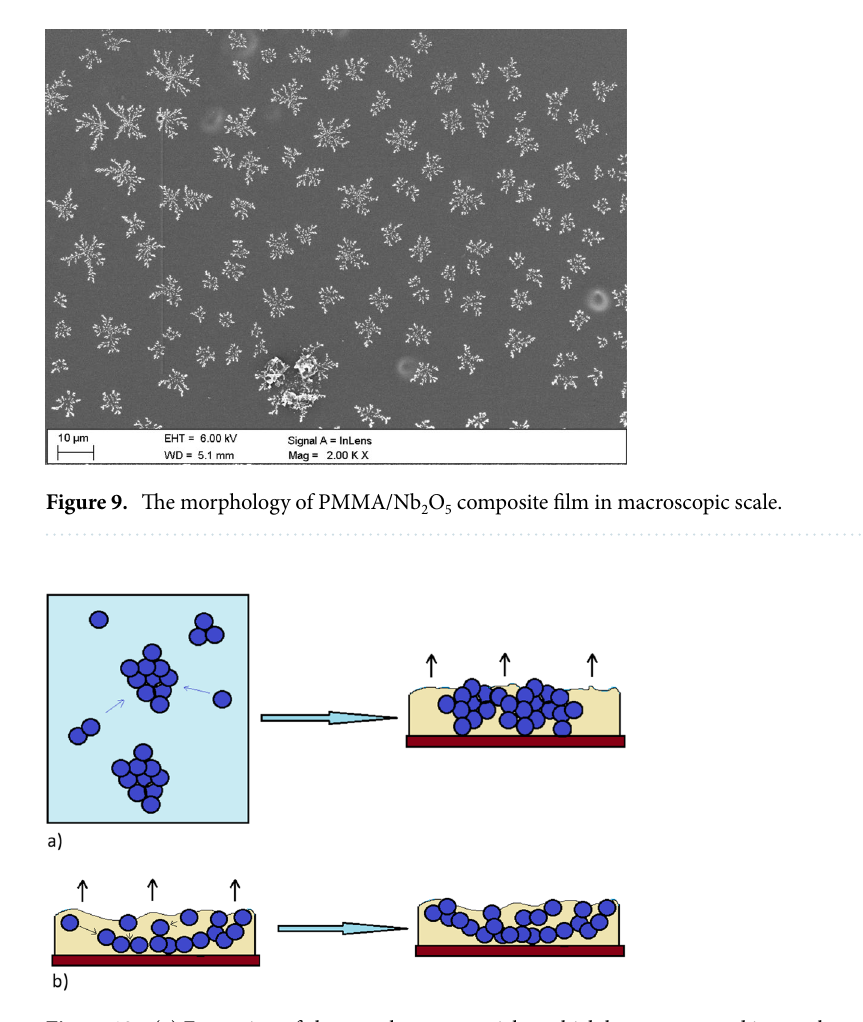
Figure 10. ( a ) Formation of clusters: the nanoparticles, which have aggregated in conglomerates in solution, are forming bigger clusters during casting the solution and evaporation of solvent. ( b ) Snowflake formation: individual nanoparticles and nanoparticles in small conglomerates aggregate during solvent